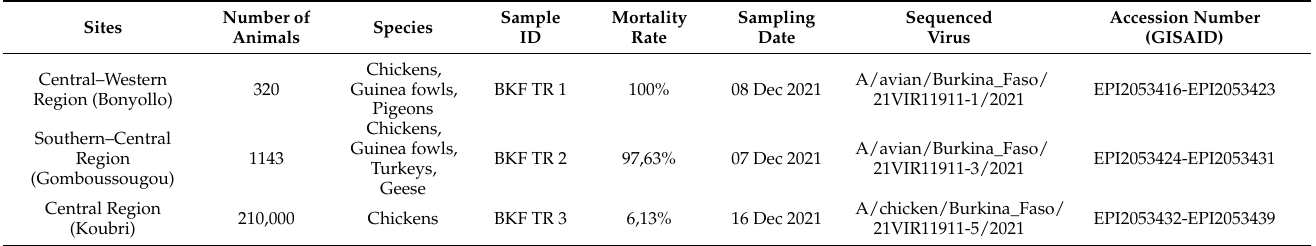
Table 1. Epidemiological